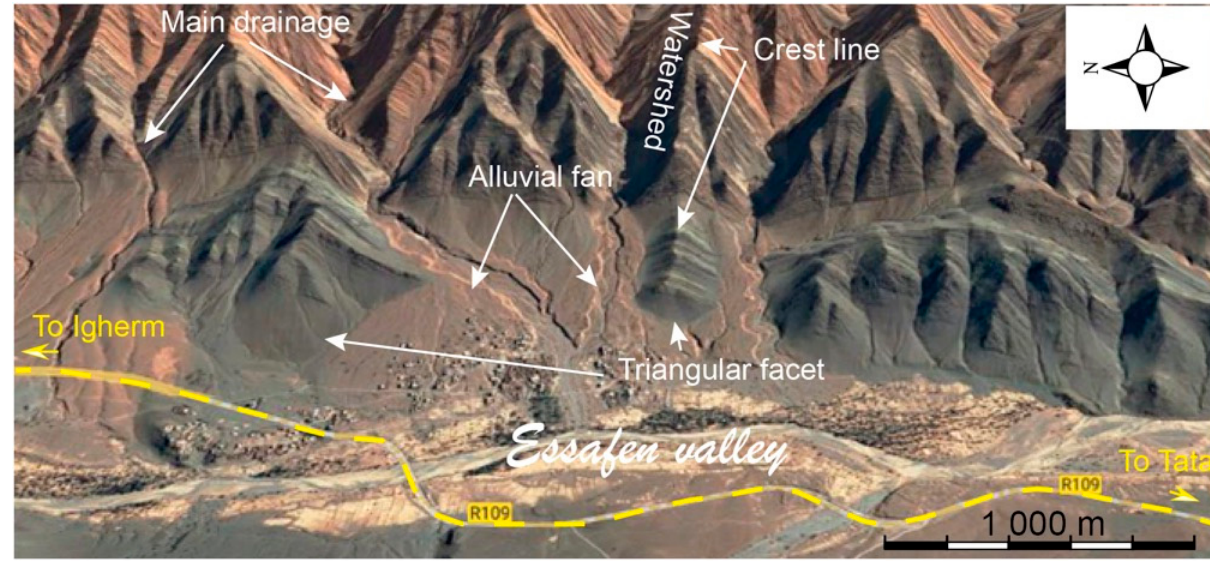
Figure 3. Morphological markers developed along the Issafène escarpment (Google